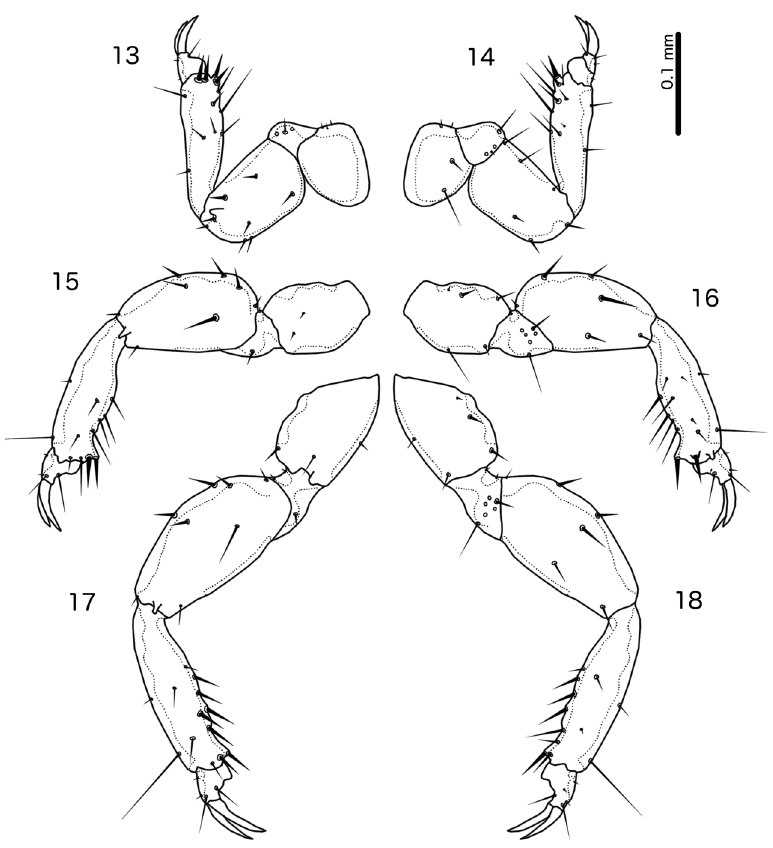
NHMUK010682494 (NHMUK). 13 . Male leg I, dorsal view. 14 . Male leg I, ventral view. 15 . Male leg II, dorsal view. 16 . Male leg II, ventral view. 17 . Male leg III, dorsal view. 18 . Male leg, III, ventral